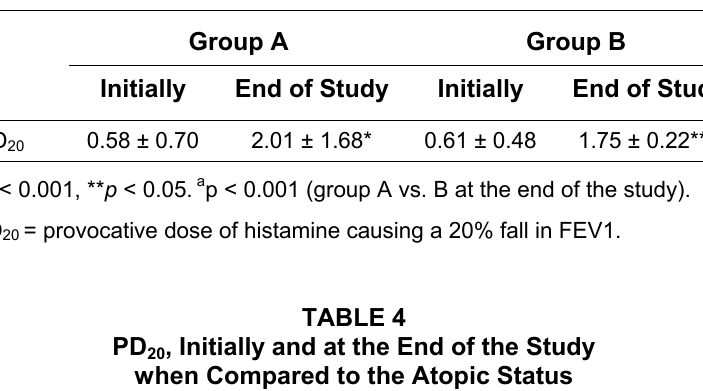
PD , Initially and at the End of the Study 20